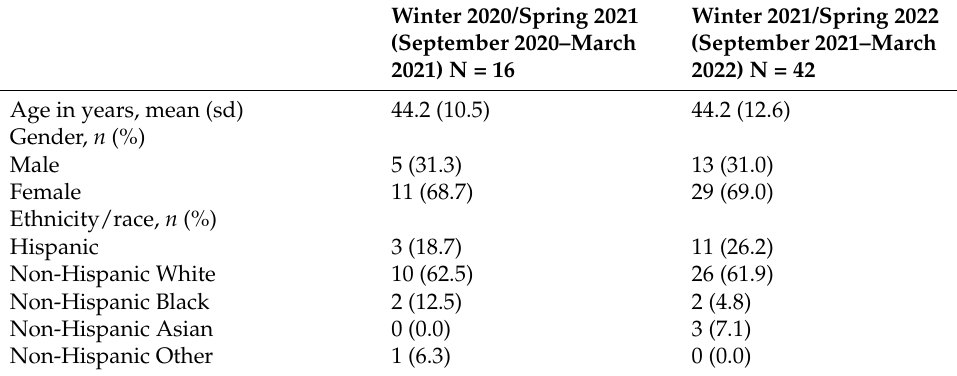
Table 4. Comparison of characteristics of HAFTRAP participants between winter 2020/spring 2021 and winter 2021/spring